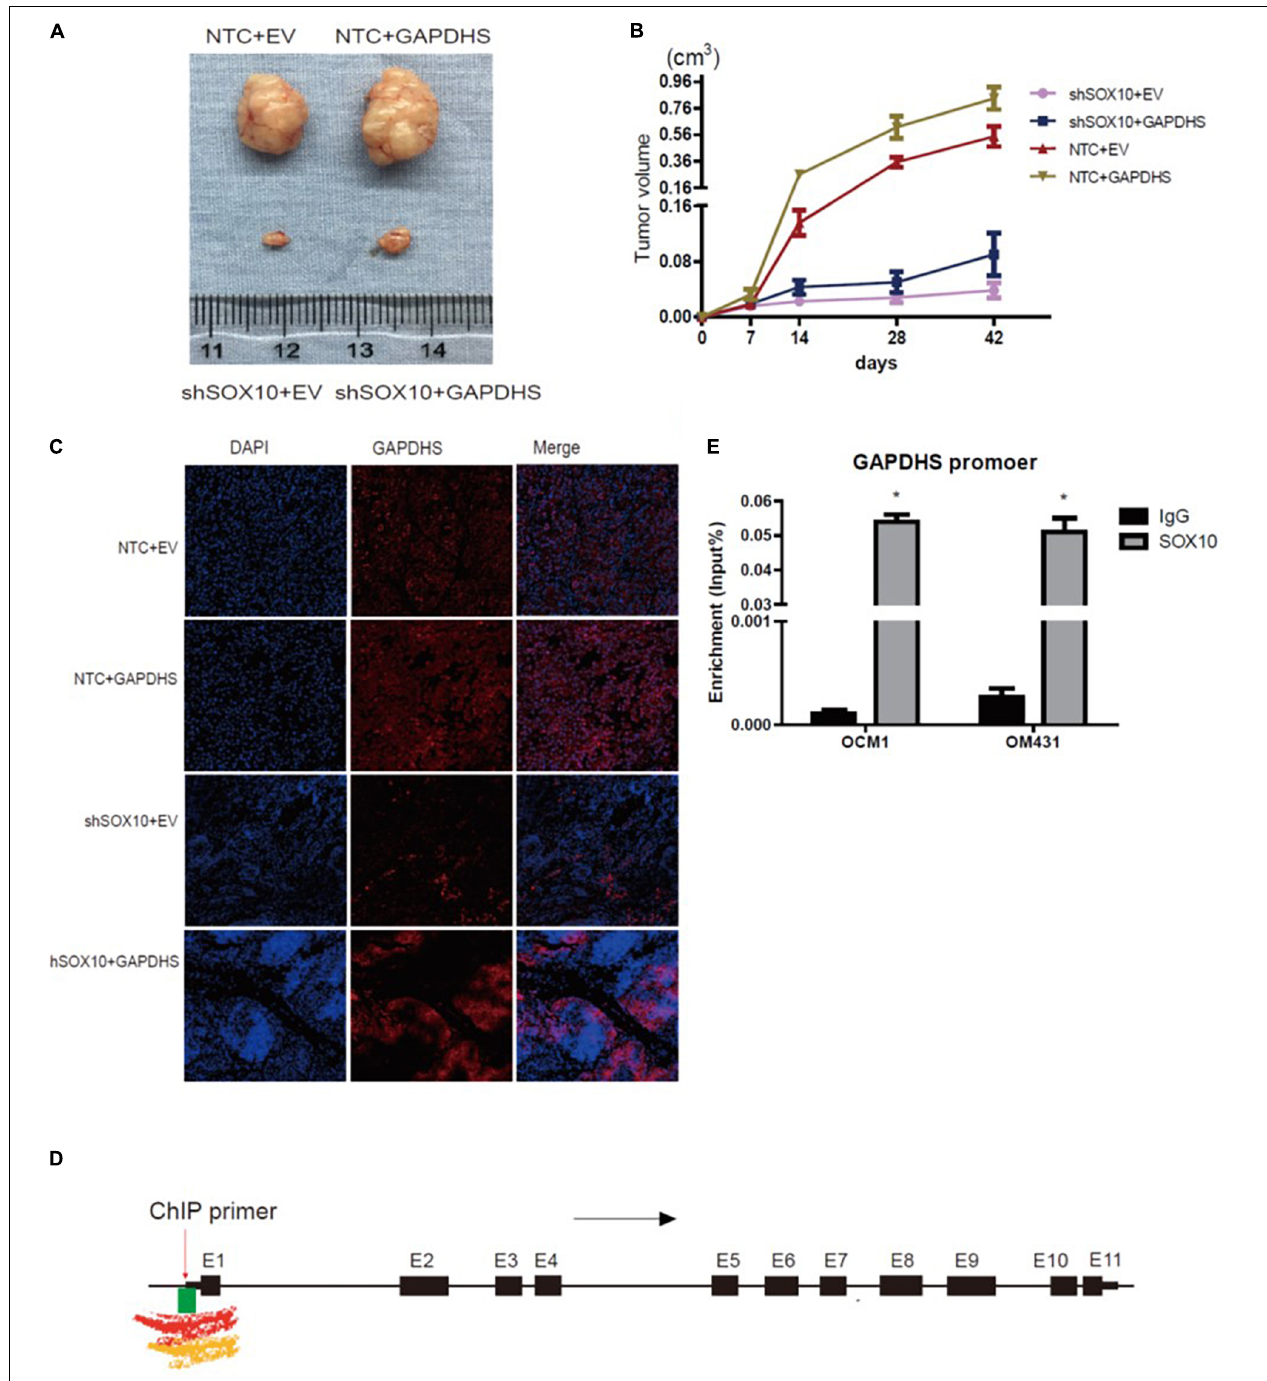
FIGURE 7 | The mechanism of glyceraldehyde-3-phosphate dehydrogenase (GAPDHS) regulated by SOX10. (A–C) SOX10 regulates GAPDHS expression in an in vivo xenograft model assay ( n = 6 for each group). (A) Tumor sizes on the 42nd day were compared at the end of the experiment. (B) Tumor growth curves were measured starting at 7 days after inoculation. (C) Representative immunohistochemistry (IHC) analysis of GAPDHS protein expression in tissues from nude mice. (D) Overview of H3K4me1, H3K4me3, and CpG island binding sites in the regulatory region of GAPDHS from the UCSC database. Black arrow, transcription direction; red arrow, chromatin immunoprecipitation (ChIP) primer used in this study, located upstream of the first exon of GAPDHS; black box, exons of GAPDHS; E1 through E11, number of exons; green box, CpG island enrichment around the first exon; red waveform, Encode Enhancer- and Promoter-Associated Histone Mark (H3K4me1) enrichment around the first exon; yellow waveform, Encode Promoter-Associated Histone Mark (H3K4me3) enrichment around the first exon. (E) ChIP analysis of OCM1 and OM431 cell lysates showing SOX10 recruitment to the GAPDHS promoter region. ∗ P < 0.05.